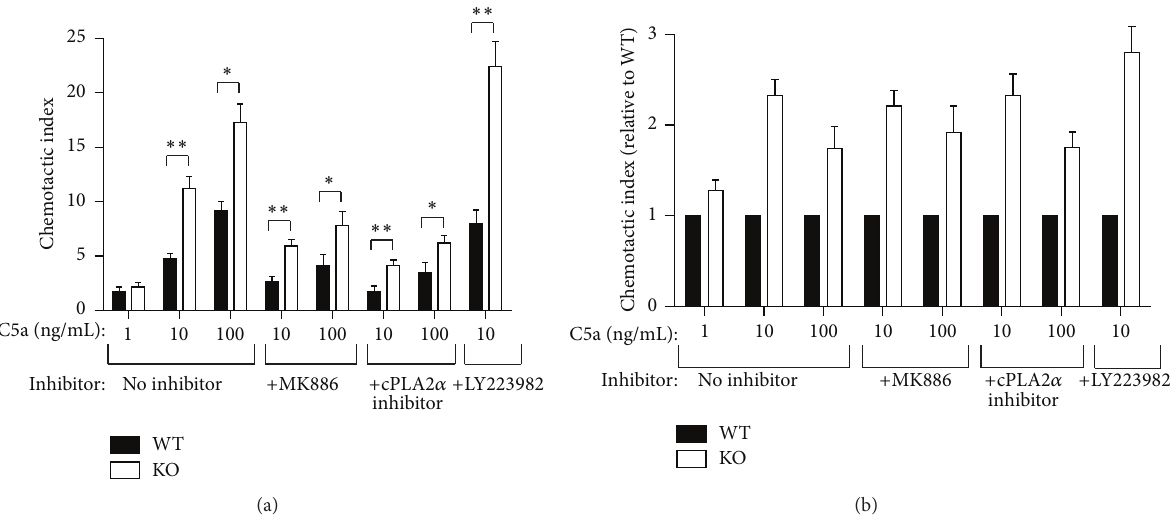
Figure 2: Cyp4f18 knockout neutrophils show increased C5a-dependent chemotaxis compared to wild-type. Chemotaxis of bone marrow neutrophils from wild-type (WT) and Cyp4f18 knockout (KO) mice was measured using C5a as a chemoattractant. Prior to chemotaxis, the neutrophils were incubated with or without the FLAP inhibitor MK 886 (0.5 𝜇 M), a cPLA2 𝛼 inhibitor (CID 9833099, 1 𝜇 M), or a BLT1 antagonist (LY223982, 10 𝜇 M). (a) Chemotactic index represents the number of cells migrated in response to C5a divided by background (error bars represent SEM, 𝑛 = 5 , ∗ 𝑃 < 0.05 , ∗∗ 𝑃 < 0.01 ). (b) Schematic plot for the relative difference in chemotactic index in Cyp4f18 knockout neutrophils compared to wild-type for each experimental